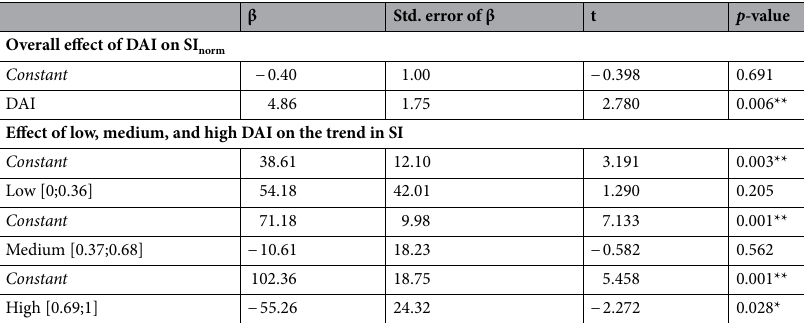
Table 2. Linear regression models of the overall effect of DAI on SI and its regression per class (low, medium, high). * p ≤ 0.05; ** p ≤ 0.001. The regression coefficient (β) is the degree of change in the outcome variable for every one-unit change in the predictor variable. The t-statistic is the regression coefficient divided by its standard error. Digital adoption is expressed in arbitrary units of DAI. The numbers in squared brackets indicate the intervals of the